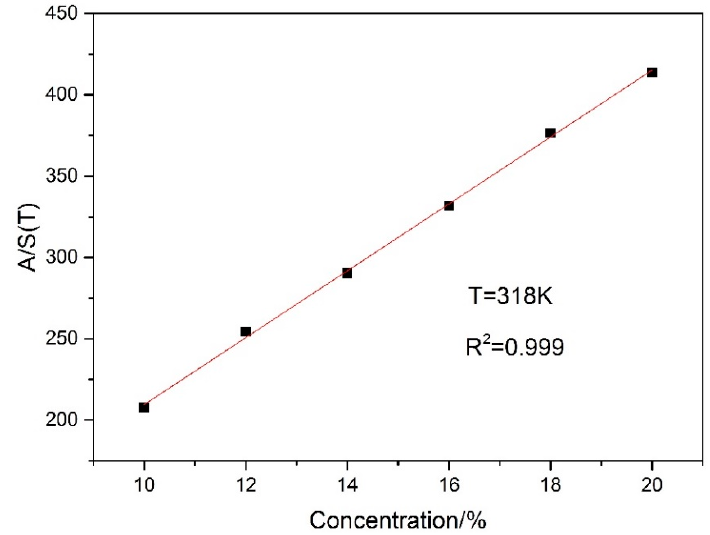
Figure 8. Integrated absorbance and spectral intensity with temperature change (14% CO 2 ).